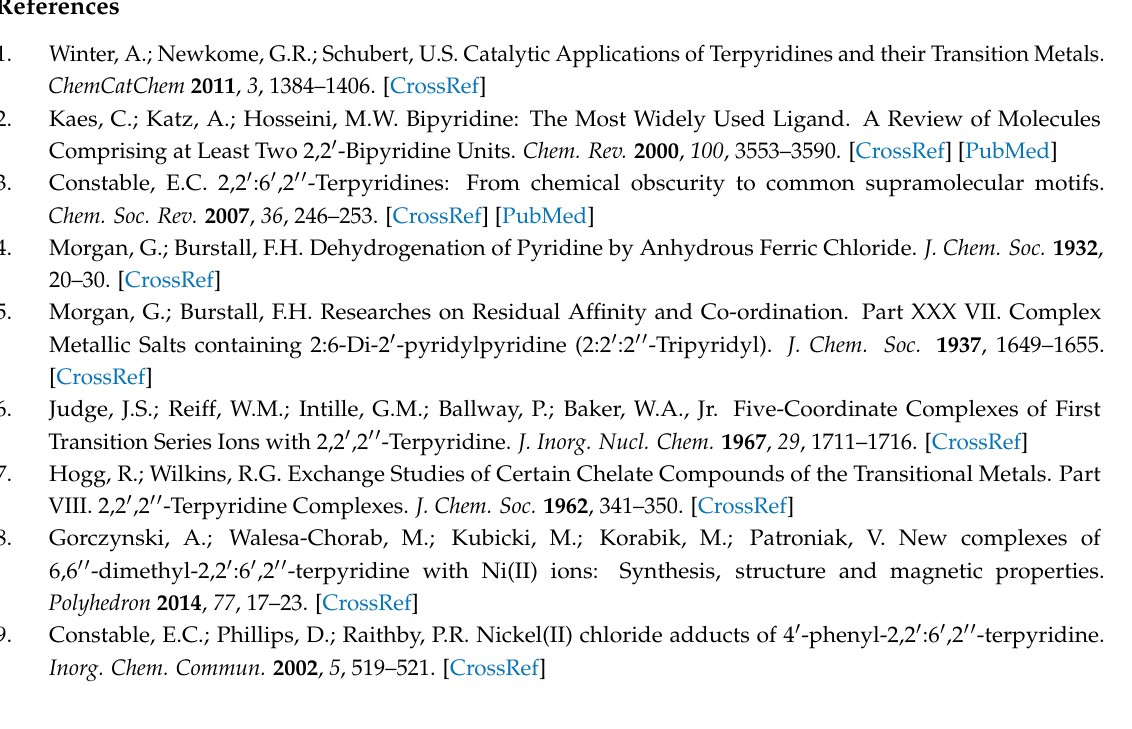
Figure 1. Cyclic voltammograms of [Ni(tpy)Br 2 ] (0.01 M) in the presence of increasing quantities of C 6 F 13 I. Ratios of complexes to R F I are 1:0 (red); 1:3 (blue); 1:6 (violet); 1:12 (dark blue); 1:30 (black). Reproduced from ref. [53] with permission form The Royal Society of Chemistry.